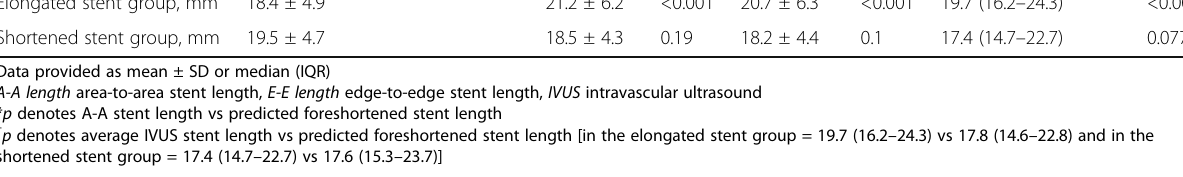
Table 6 IVUS stent lengths vs predicted foreshortened stent length Predicted foreshortened